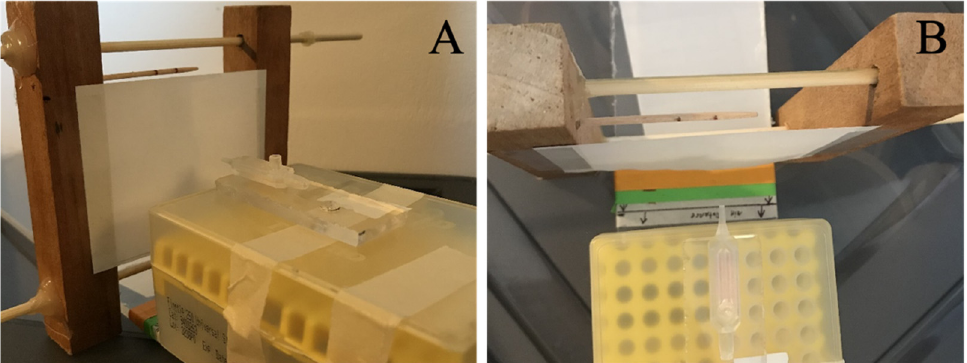
Figure 4. Aerosolized spray analysis. ( A ) Side-view and ( B ) top-view of the aerosolizer testing apparatus. The first edge of green tape represents 5 mm from the aerosolizer tip, and the first edge of orange tape represents 11 mm from the aerosolizer tip. The white paper was coated in petroleum jelly so that droplets could be seen. The toothpick at the top of the paper was marked at a known 1 cm for use later in image